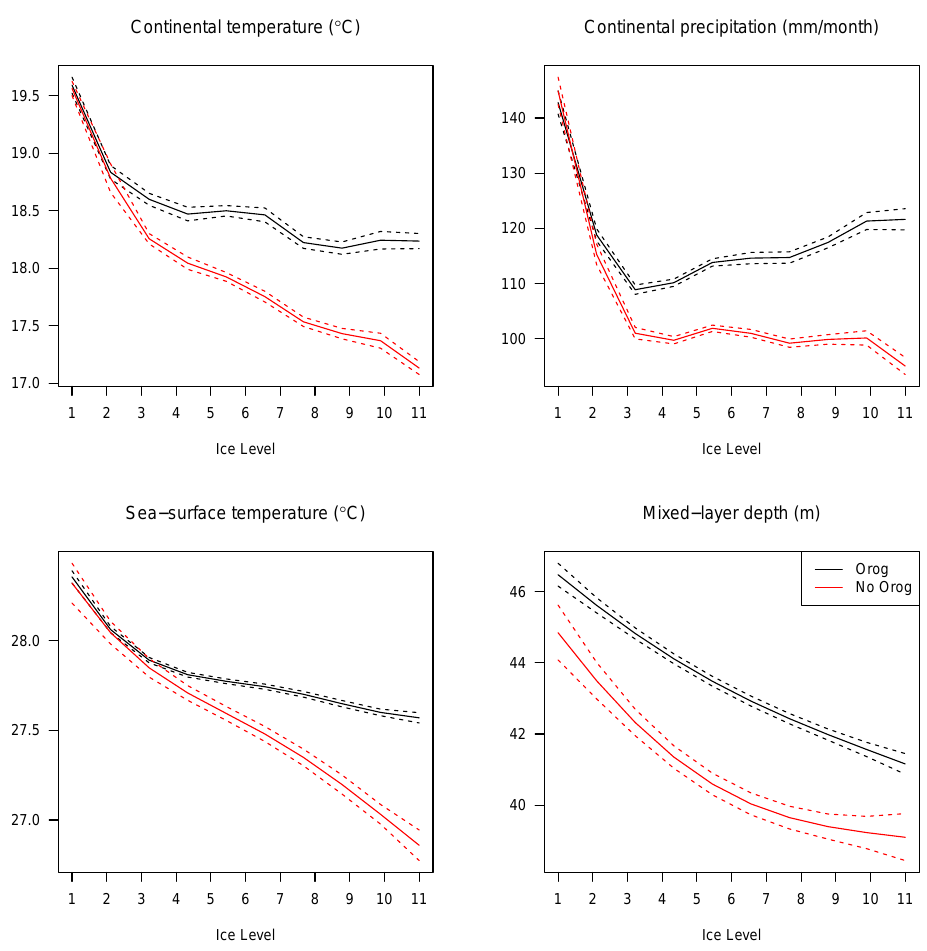
Figure 13. Orography–no-orography difference. From top to bottom, left to right: effect on continental temperature, precipitation, sea-surface temperature, and mixed-layer depth, with orography forcing (black) and without (red). The dotted lines show one standard deviation of the emulator prediction. One may see a departure point from glaciation level 3 in all four fields, as this is the point at which orography forcing becomes the most